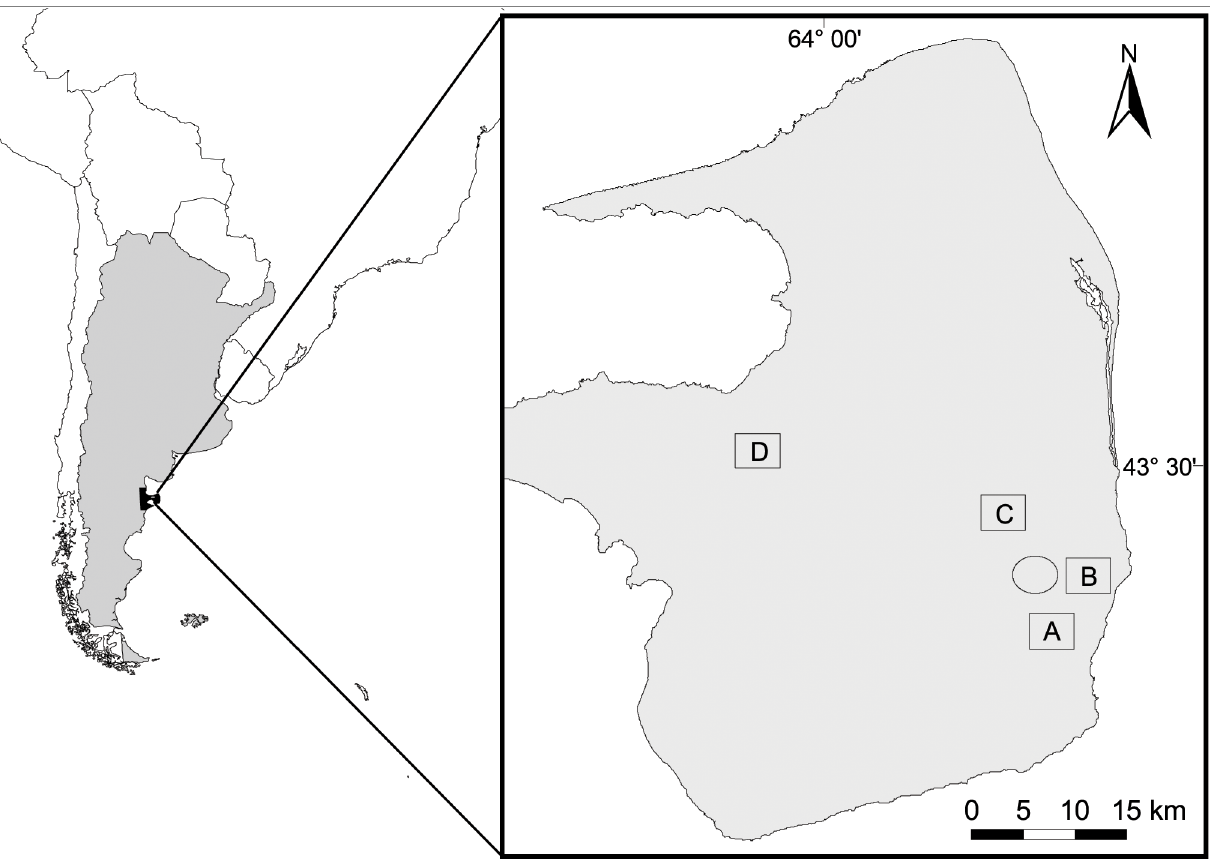
Fig 1. Study site location. Map showing the location of Península Valdés (Argentinean Patagonia) in South America (left panel) and sampling sites (right panel). Rectangles show the location of the four 2000-ha areas used to search for warrens and estimate detectability and false positive bias, while the circle shows the location of the 12 warrens surveyed to quantify bias in the counts. A and B indicate the sites placed in grassland, C and D the sites placed in shrub- grass. We have created the image ourselves using ArcView 3.2.